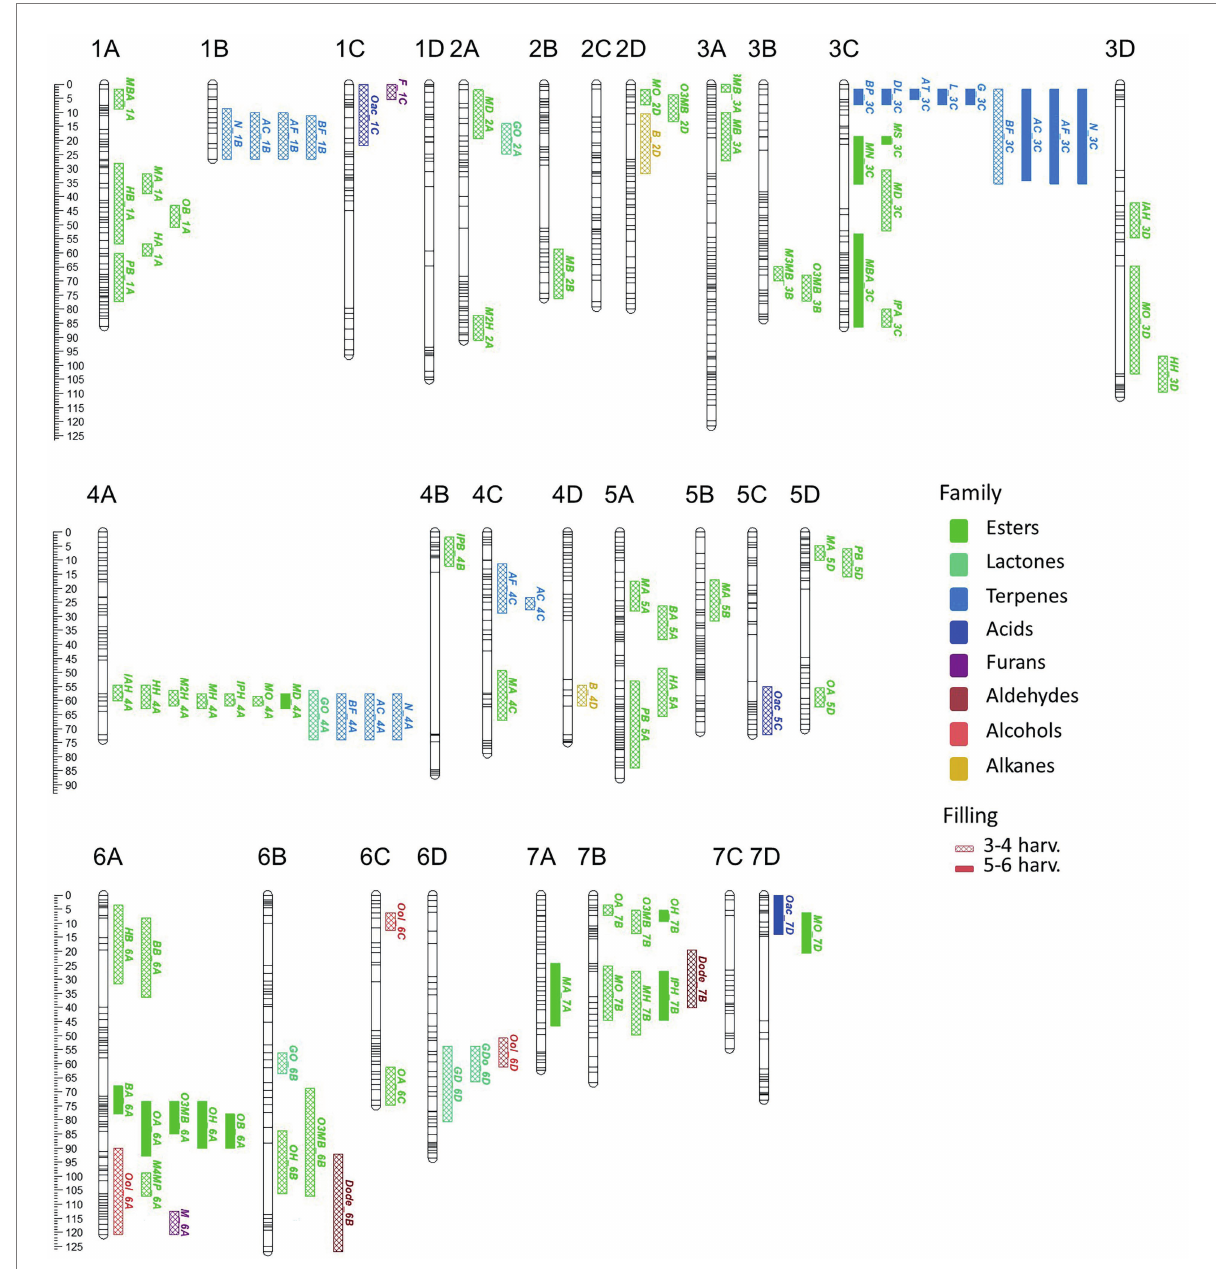
FIGURE 3 VOC_QTL location in the “FC50 × FD54” genetic map. Box size correspond to the 1-LOD confidence interval. Stability is represented by box filling degree: consistent in five or six harvests (filled) and detected in three or four harvests (semi-filled). Chemical family compounds are differentiated by colors: acids (light blue), alcohols (red), aldehydes (yellow), alkanes (dark red), esters (green), furans (purple), lactones (turquoise) and terpenes (dark